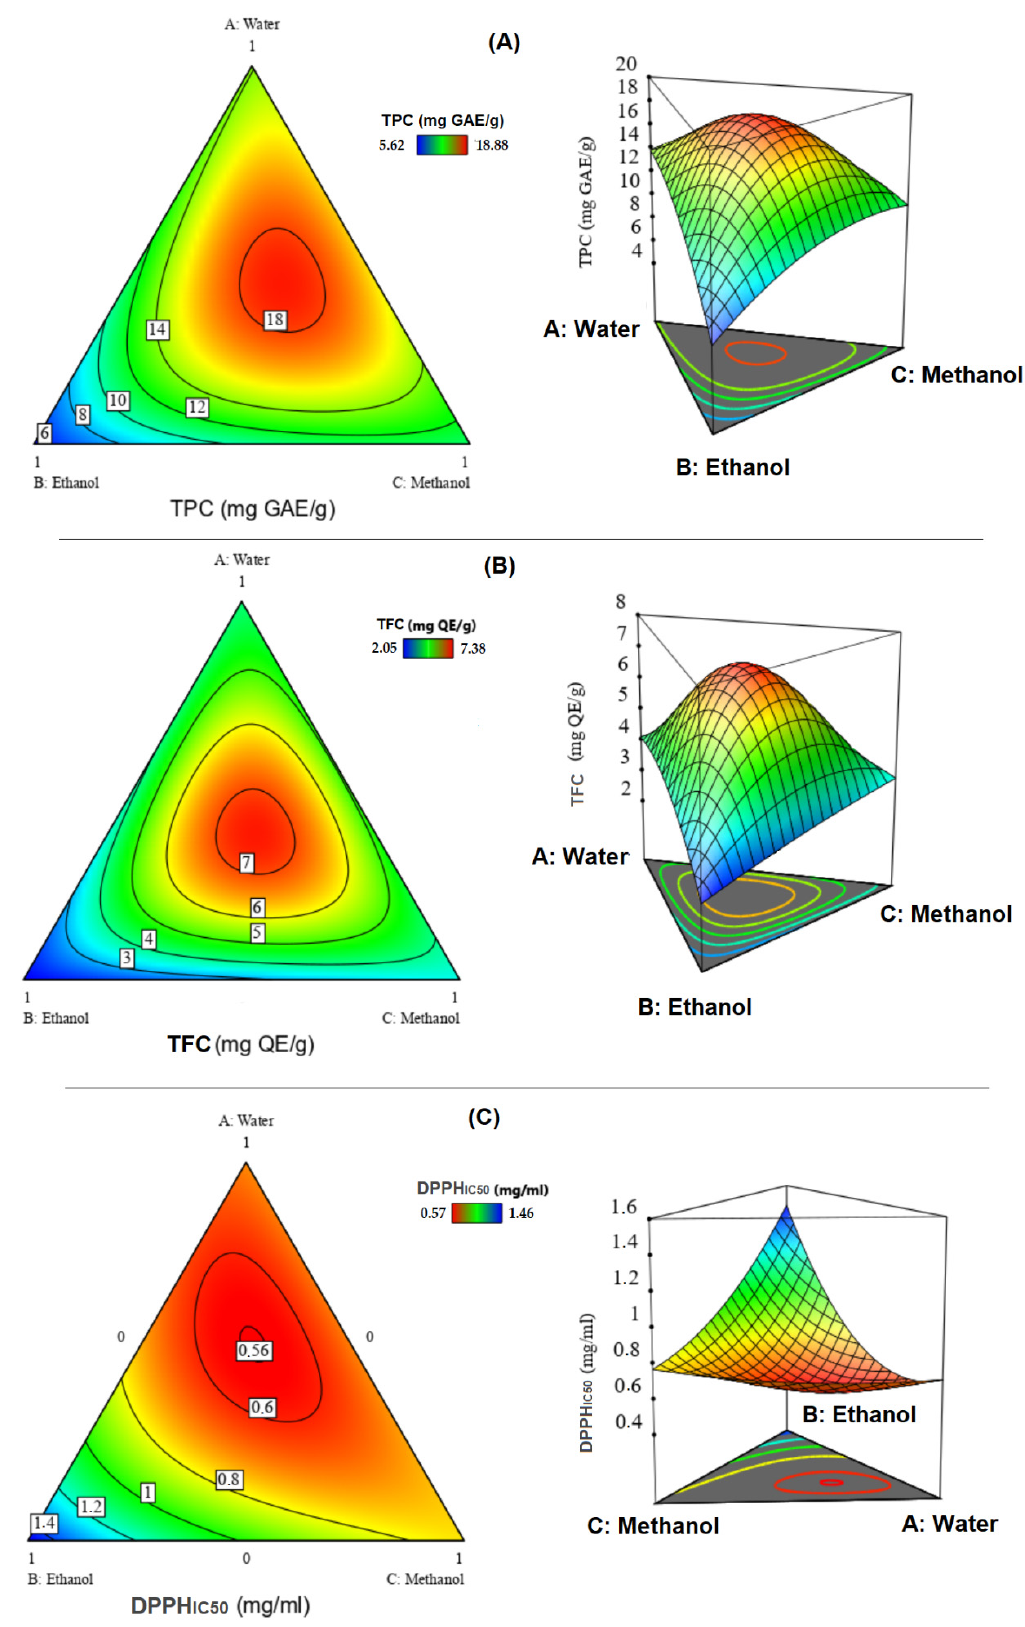
Figure 4. Contour and surface plots, which indicate the optimal compromise area leading to the best value of TPC ( A ), TFC ( B ) and DPPH IC50 ( C ).